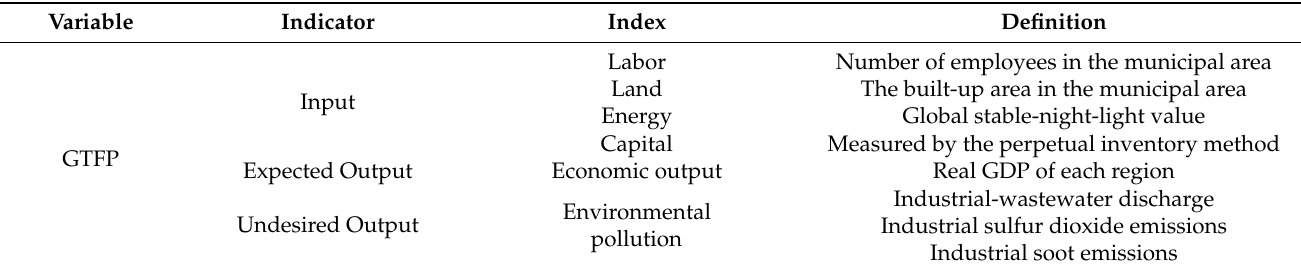
Table 1. Indicator index system for GTFP in